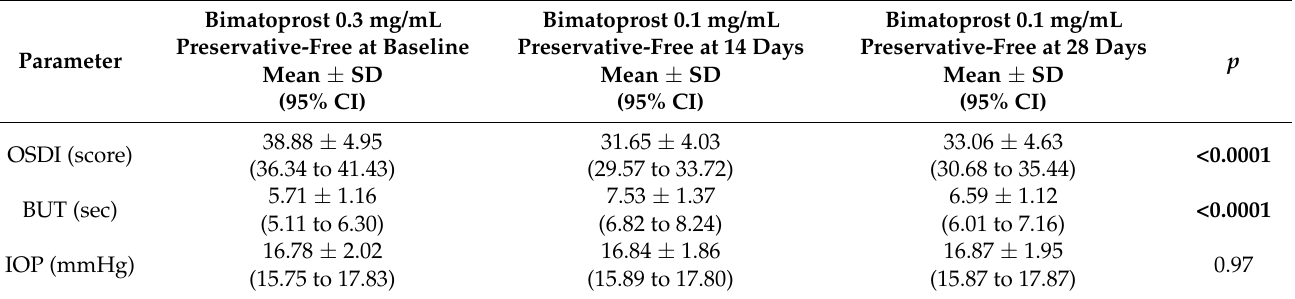
Table 4. Comparisons between Bimatoprost 0.3 mg/mL preservative-free at baseline and Bimatoprost 0.1 mg/mL preservative-free at 14 and 28 days relative to ocular parameters.